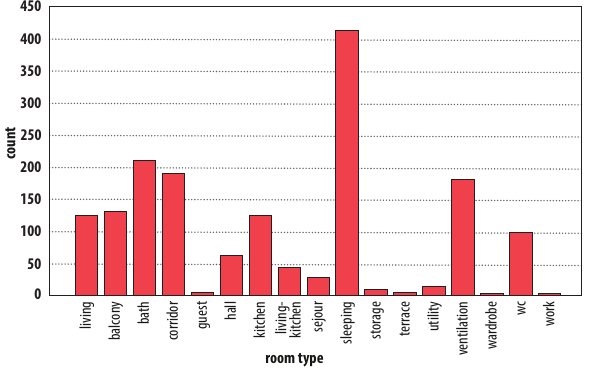
Figure 5. A histogram of the different functional uses of rooms taken into consideration in our experiments.